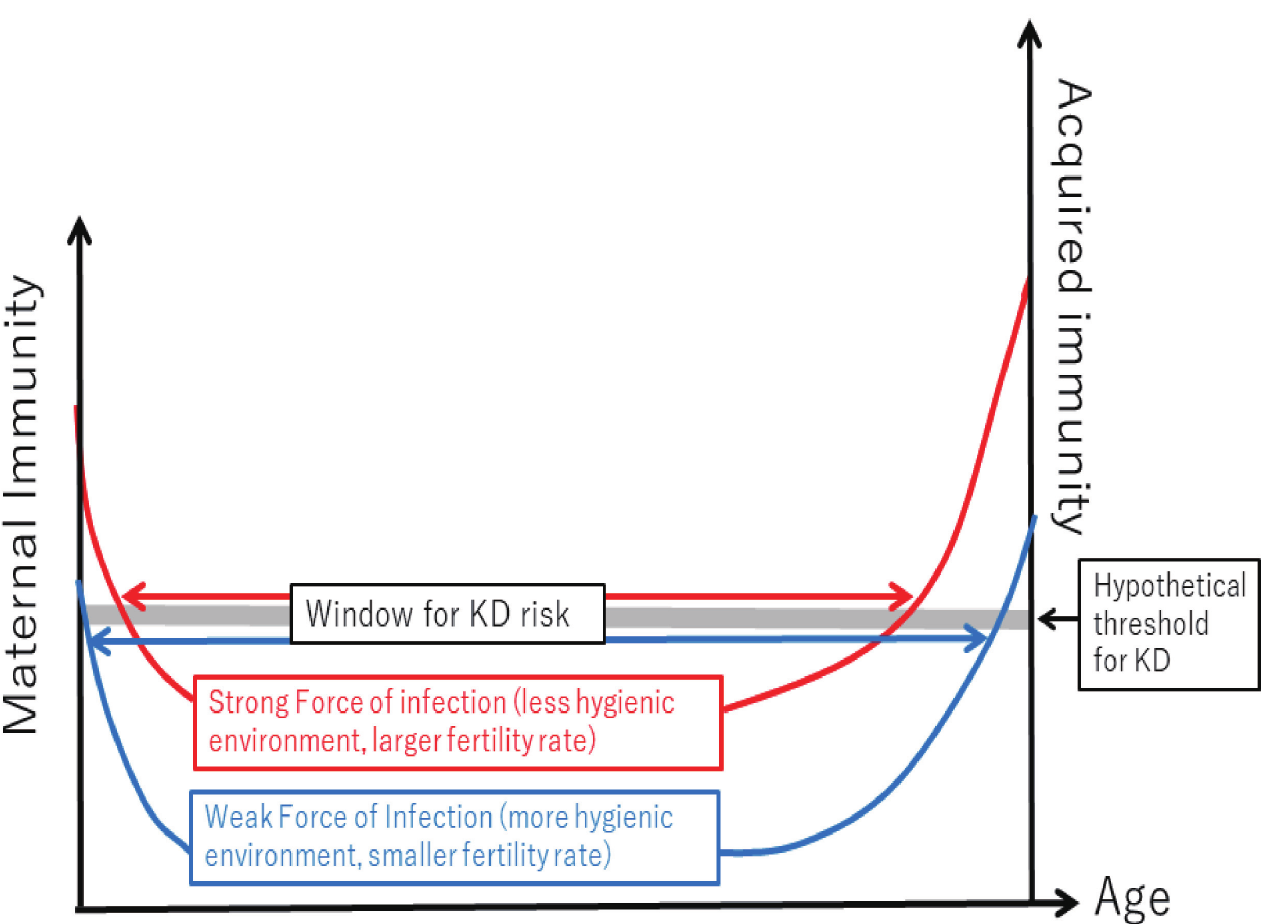
Fig 7. Hypothesis that explains and predicts expansion of ages of KD due to decreased IgG levels. The force of infection is high in a less hygienic environment (red). As the environment becomes more hygienic, the force of infection becomes lower (blue). Under an assumption that KD occurs more frequently under a hypothetical threshold of IgG, the age window for KD risk expands into both younger and older